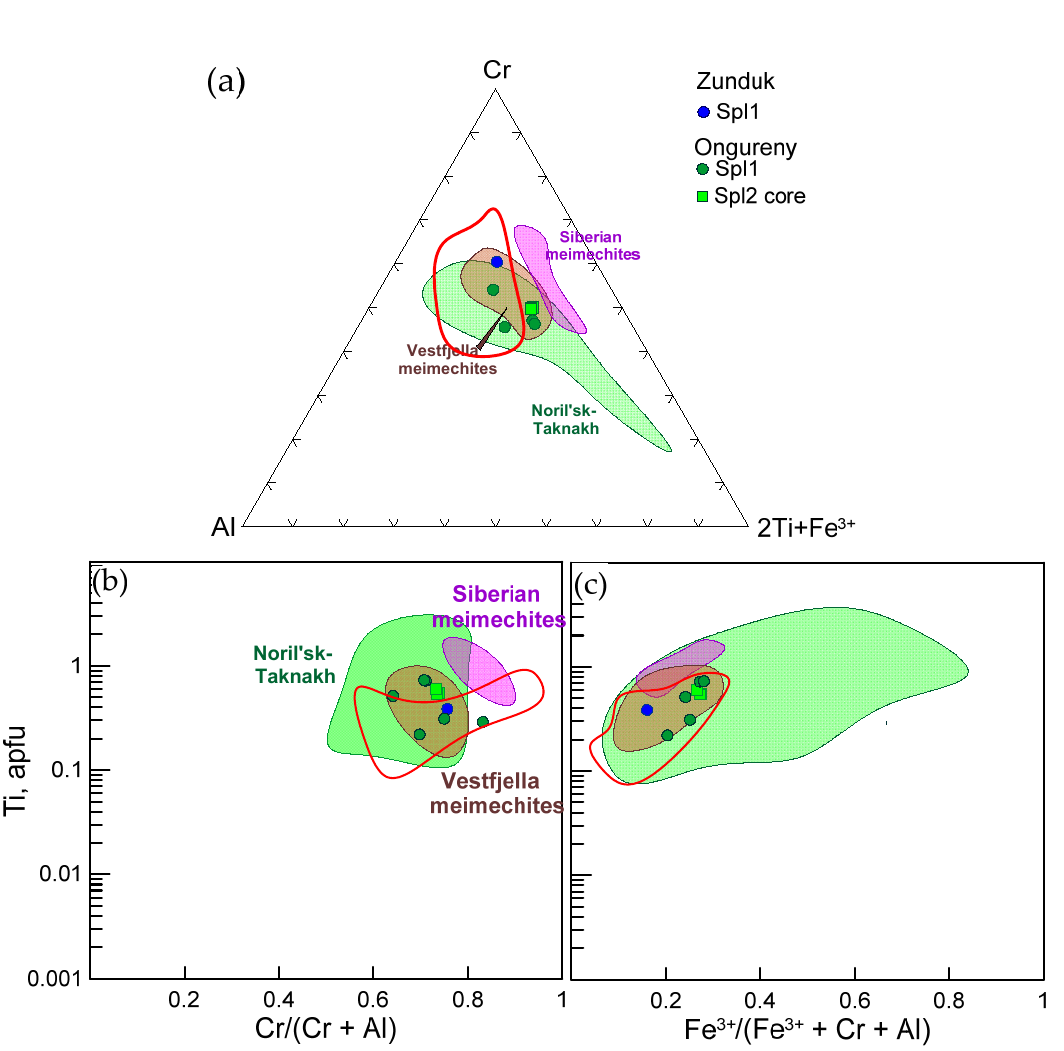
Figure 8. Compositional variations of primary Cr-spinels from ultramafic rocks of the Primorsky Ridge: ( a ) the Al-Cr-2Ti + Fe 3+ ; ( b ) Cr/(Cr + Al), and ( c ) Fe 3+ /(Fe 3+ + Cr + Al) vs. Ti (apfu on the basis of 32 oxygen anions) diagrams. The field of spinel compositions: Vestfjella meimechites [45], Siberian meimechites [46], Norilsk-Talnakh intrusions [43], and Neoproterozoic mafic-ultramafic intrusions (Tartay and Medek) (red contour) [55] are plotted for comparison.